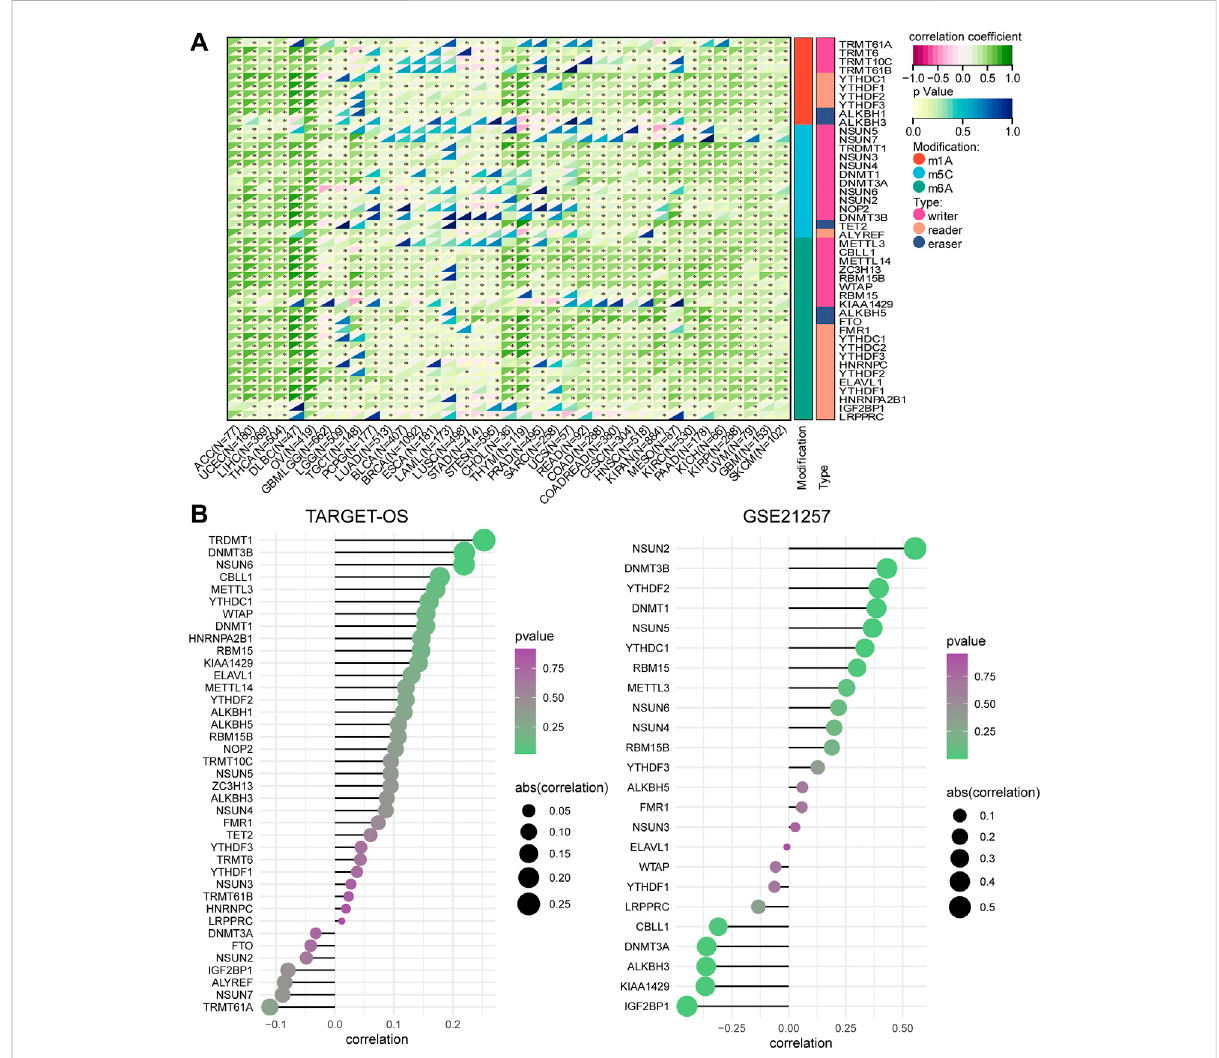
FIGURE 2 CD146 is regulated by RNA methylation. (A) Correlation of CD144 expression and RNA methylation regulators in m1A, m5C, and m6A among pan-cancer. (B) Correlation of CD144 expression and RNA methylation regulators among pan-cancer OSA